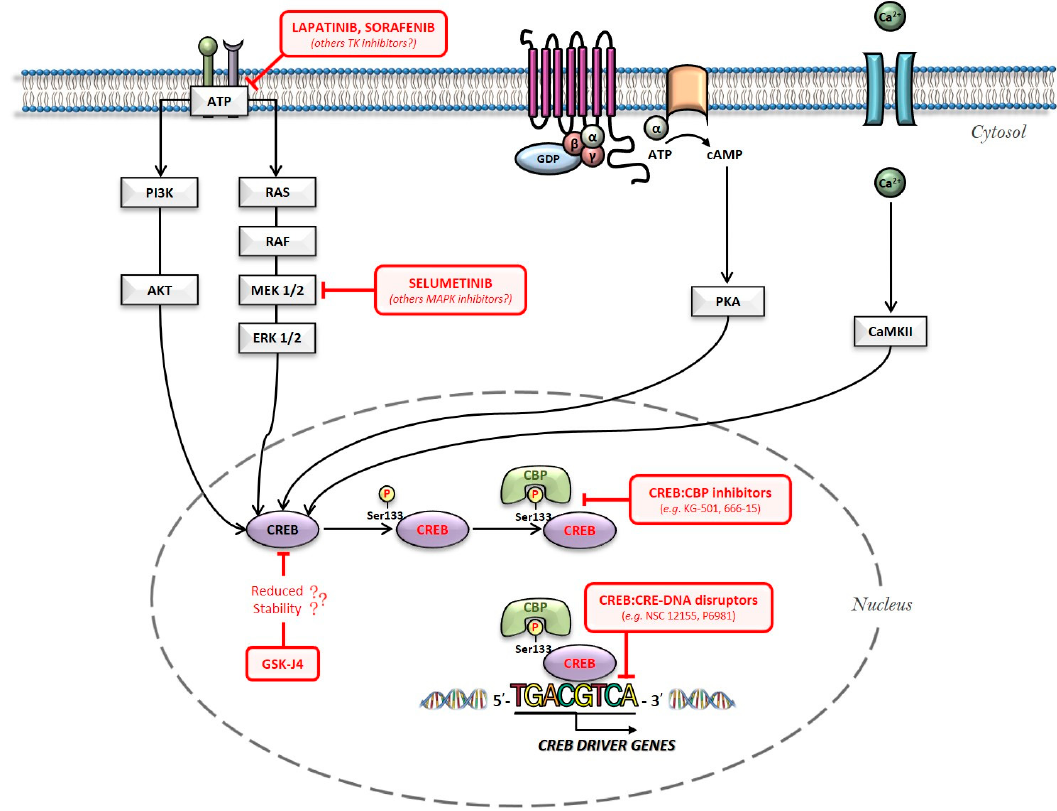
Figure 2. Overview of the main intracellular pathways involved in CREB activation: possible pharmacological hubs for its inhibition.